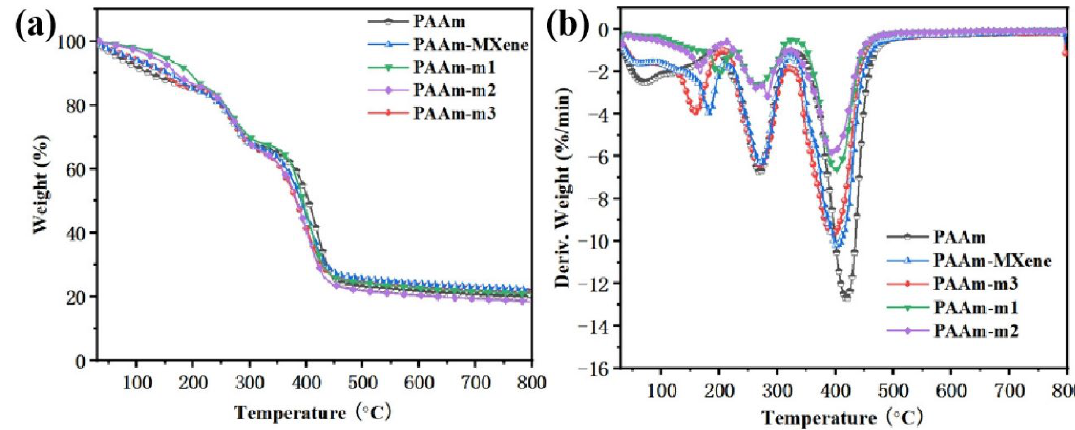
Figure 5. ( a ) TGA and ( b ) DTG curves of coatings under nitrogen atmosphere.